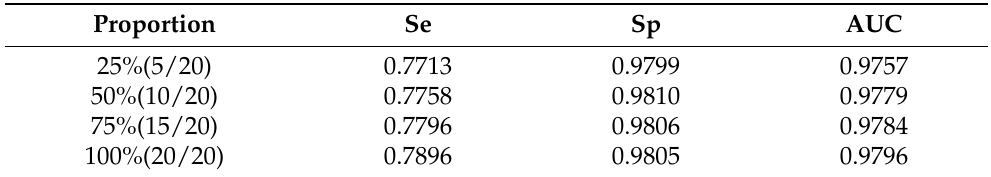
Table 16. The performance of the LightEyes when varying the number of training samples on the vessel segmentation task (DRIVE